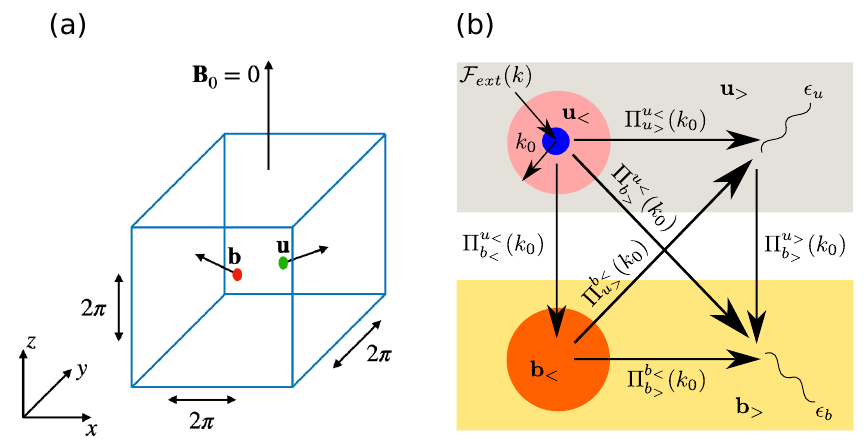
Figure 1. Schematic diagram of ( a ) a periodic simulation box where u and b respectively represent random fluctuations in velocity and magnetic field, and ( b ) various energy fluxes in MHD turbulence. These energy fluxes are destroyed in the dissipation range with viscous dissipation rate (cid:101) u and magnetic dissipation rate (cid:101) b